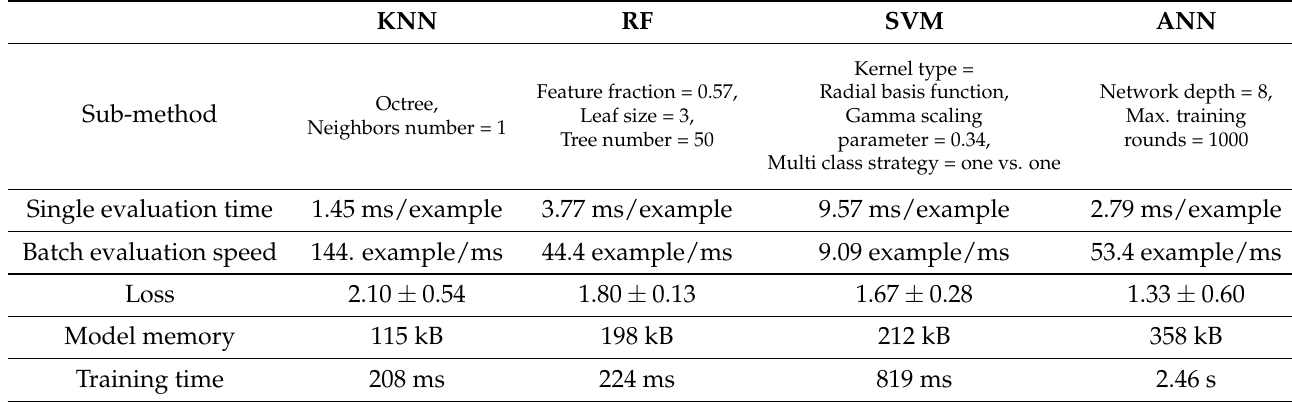
Table 2. The compared classifiers information.